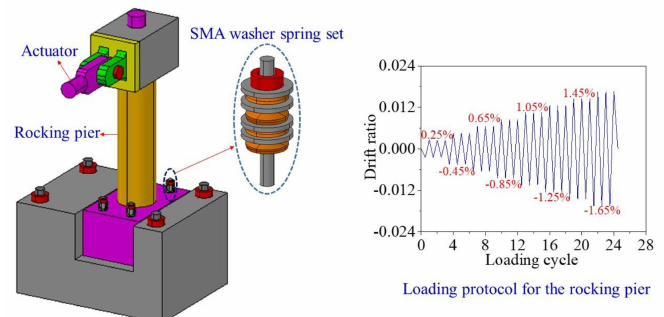
Figure 9. Configuration of a rocking pier specimen and loading